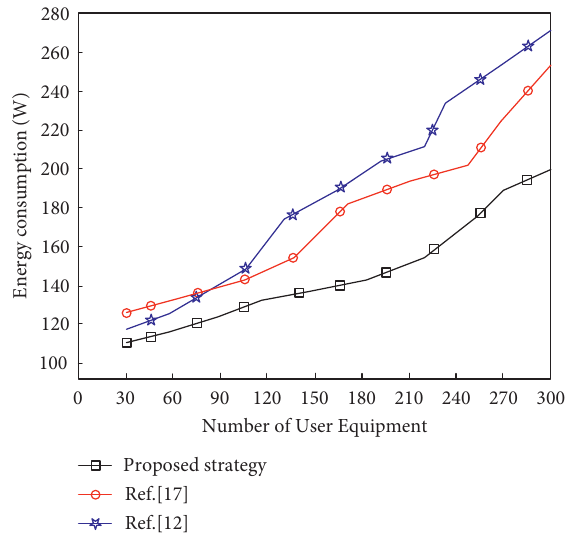
Figure 6: The relationship between energy consumption and the number of user devices of different algorithms.